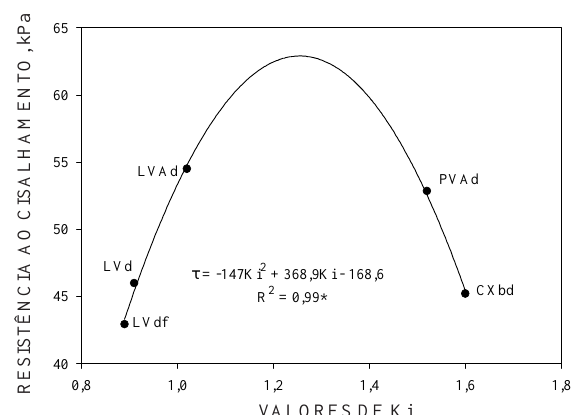
Figura 8. Variação da resistência ao cisalhamento dos solos com o índice